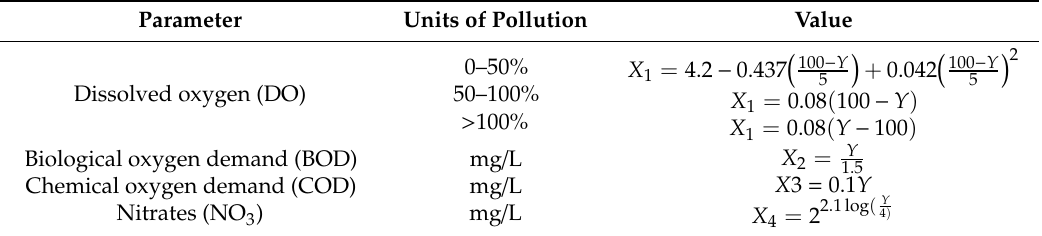
Table 3. Equations used for calculation of Prati´s Implicit Index of Pollution (IPI).